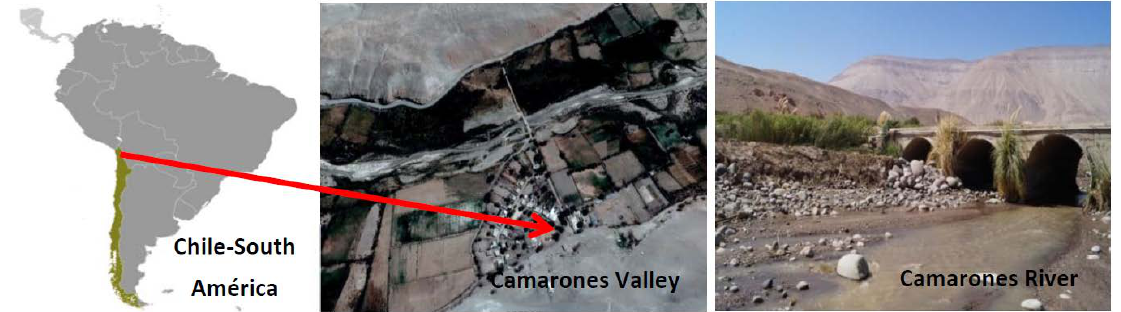
Figure 1. Geographical location of the Camarones area and photographic image of the river of the same name.